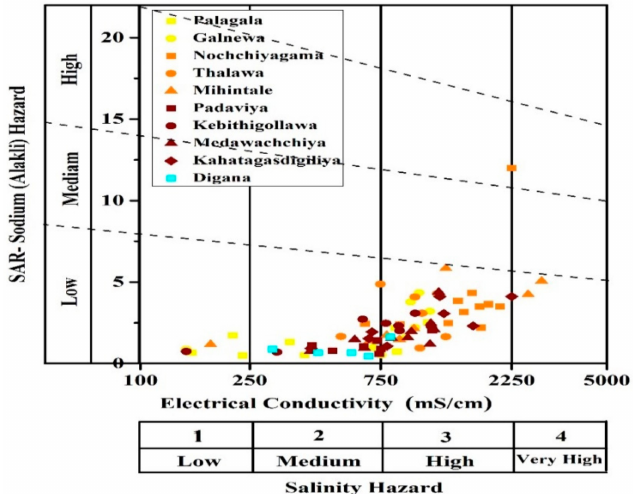
Figure 5. Salinity hazard diagram for collected water samples (dry